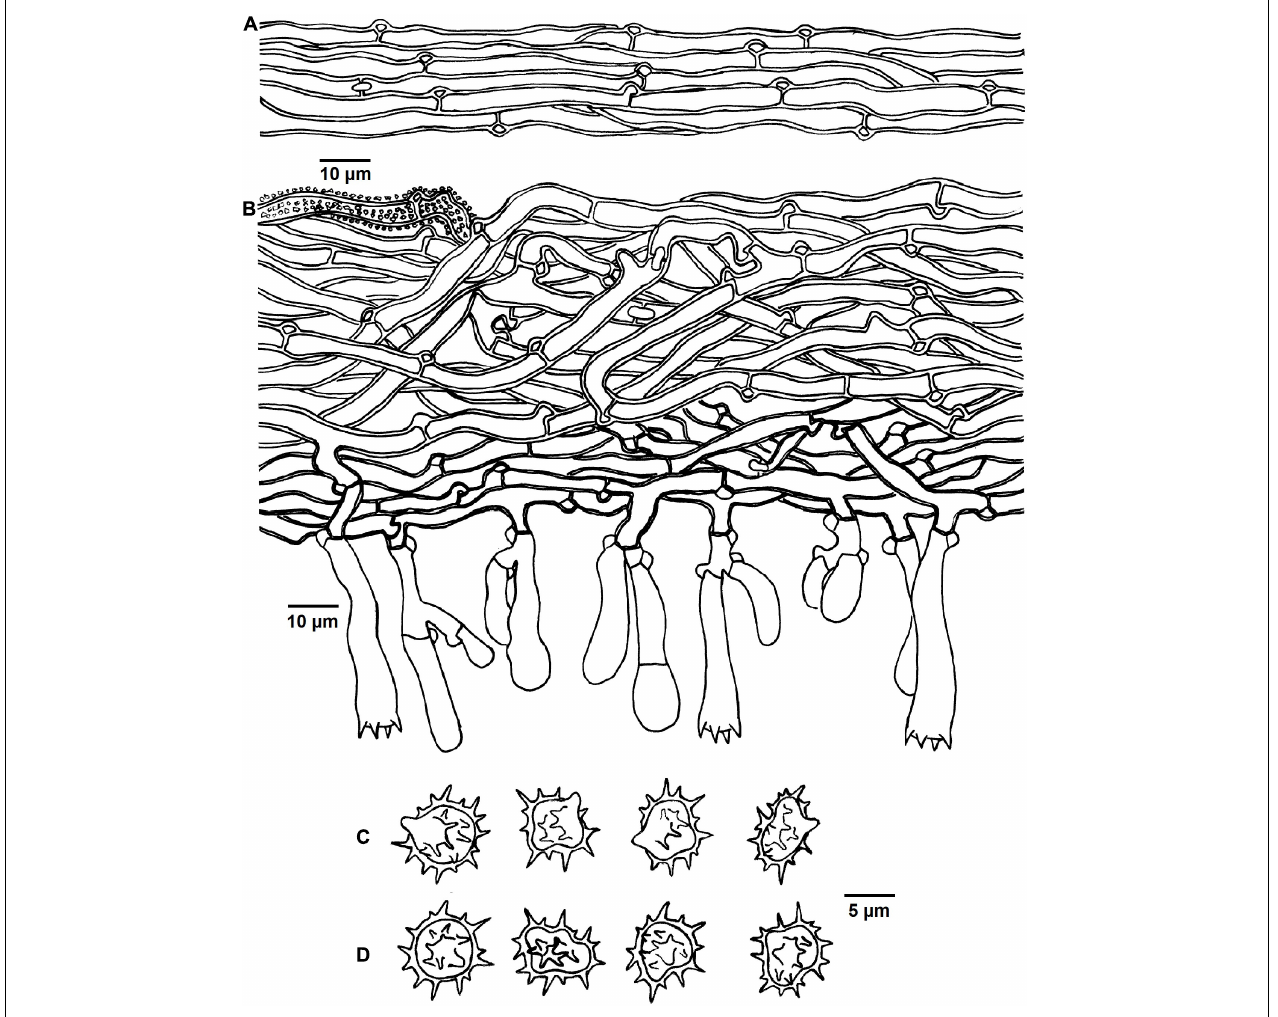
FIGURE 5 | Microscopic structures of Tomentella brevisterigmata (drawn from holotype Yuan 12700). (A) Hyphae from a rhizomorph. (B) A section through basidiocarp. (C) Basidiospores in lateral view. (D) Basidiospores in frontal view.